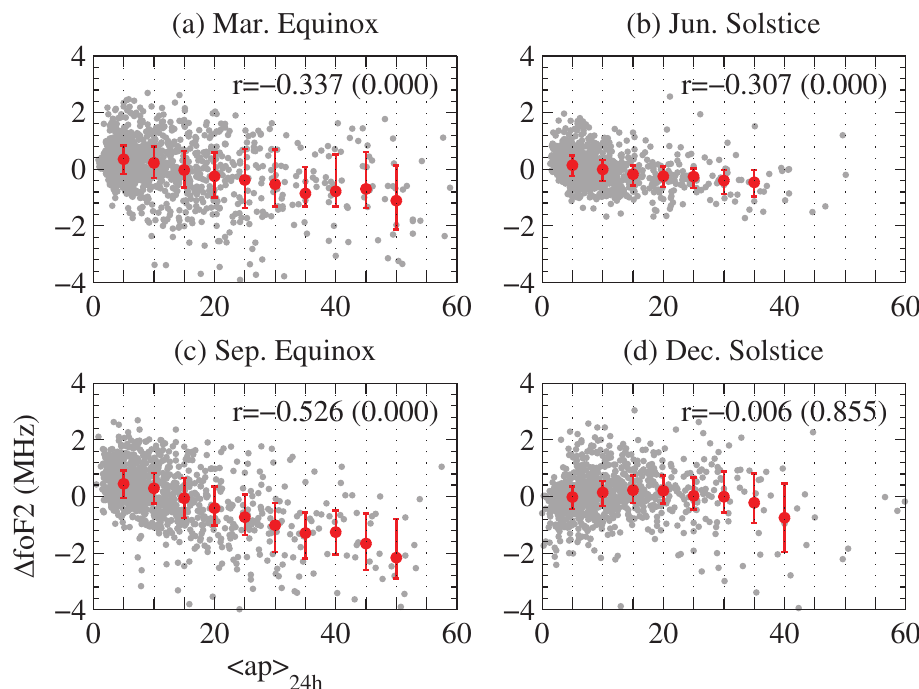
Fig. 3. Scatter plots of the observed minus fi tted f o F 2 , D f o F 2 , versus < ap > 24 h at Petropavlovsk in (a – d) four seasons; the red dots and error bars are mean values and corresponding lower and upper quartiles of gridded D f o F 2 , respectively. The parameter r is the correlation coef fi cient between D f o F 2 and < ap > 24 h , and the number in the parentheses is the corresponding P -value indicating statistical signi fi cance of the correlation coef fi